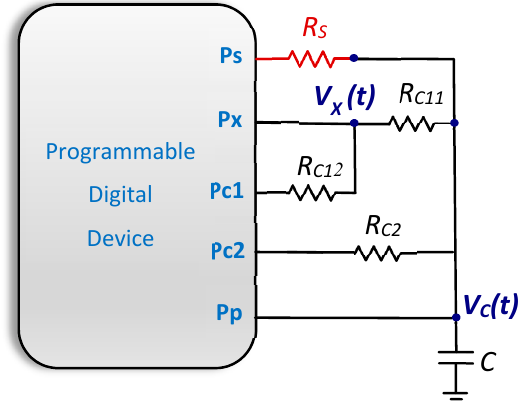
Figure 3. New resistive DIC proposed for error reduction due to different initial voltages stored on the capacitor (resistor/sensor to be estimated shown in red).